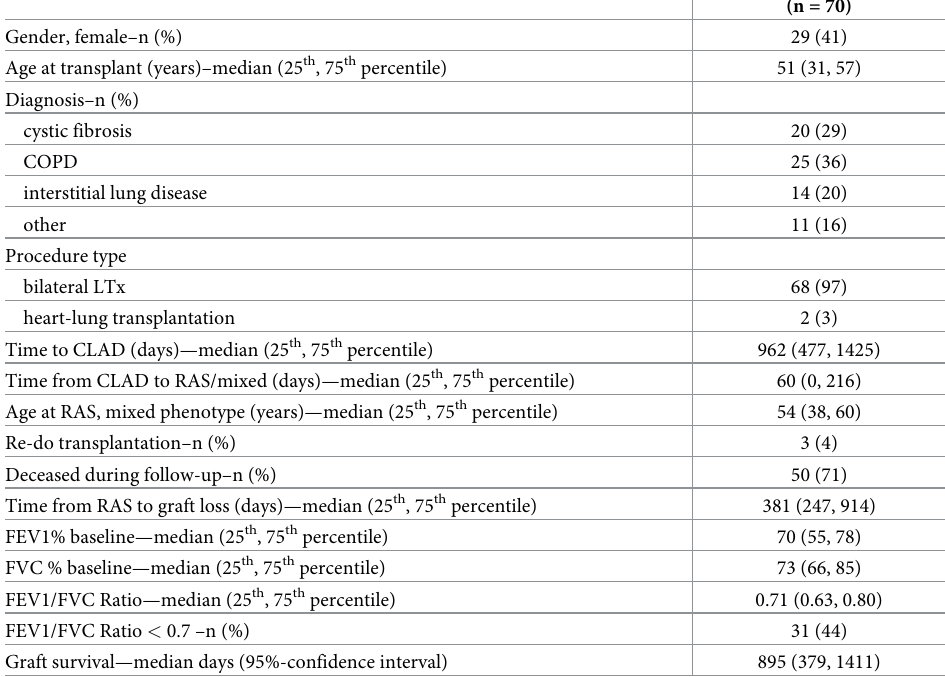
Table 1. Patient demographics.